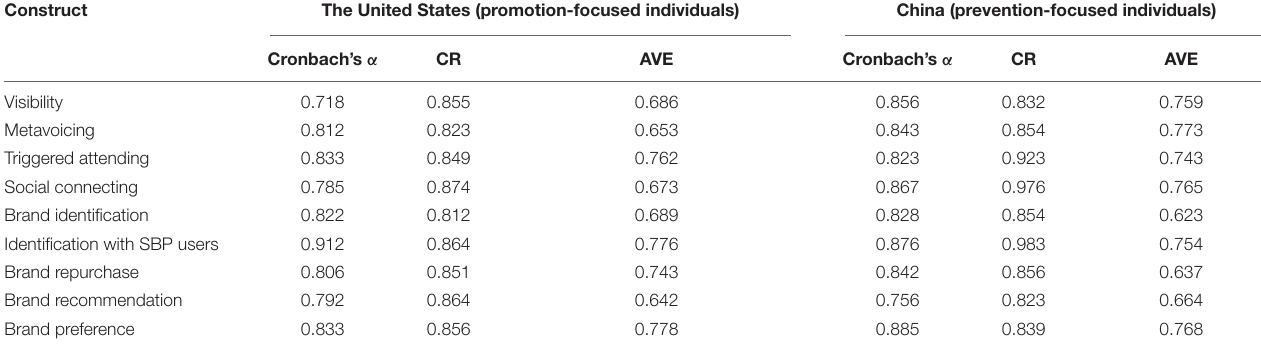
TABLE 4 | Cronbach’s α , CR, and AVE values for the constructs.